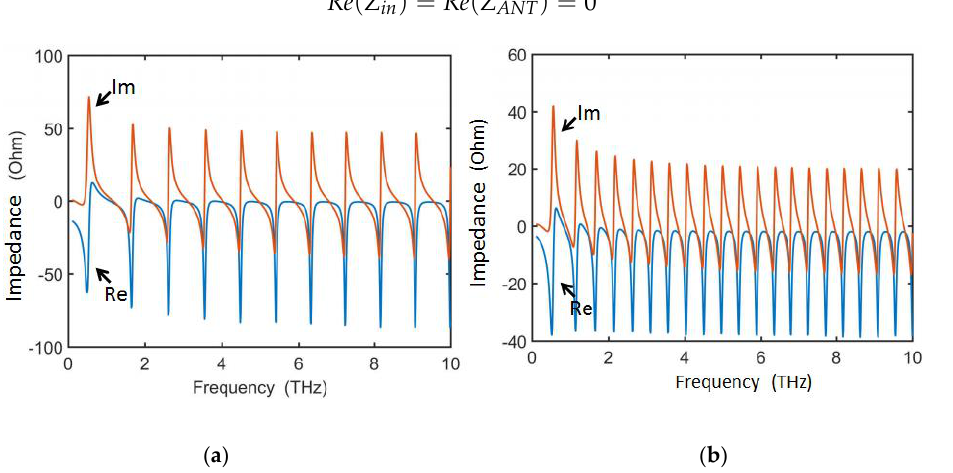
Figure 2. Relationship between impedance and frequency of transmission line: ( a ) Z in or Z’ in ( L = 1 µ m) and ( b ) Z in or Z’ in ( L = 2 µ m).